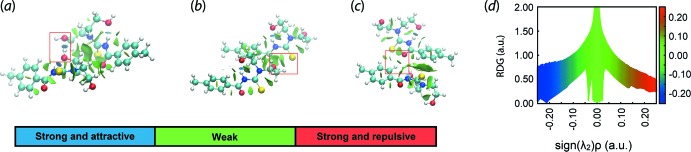
NCI plots for the dimeric aggregates in (I) sustained by (a) O—H⋯O, (b) O—H⋯S and (c) C—H⋯O inter­actions (highlighted in boxes), and (d) plot of RDG versus sign(λ2)ρ(r). The gradient cut-off is set at 0.4 and the colour scale is −0.03 < ρ < 0.03 atomic units.